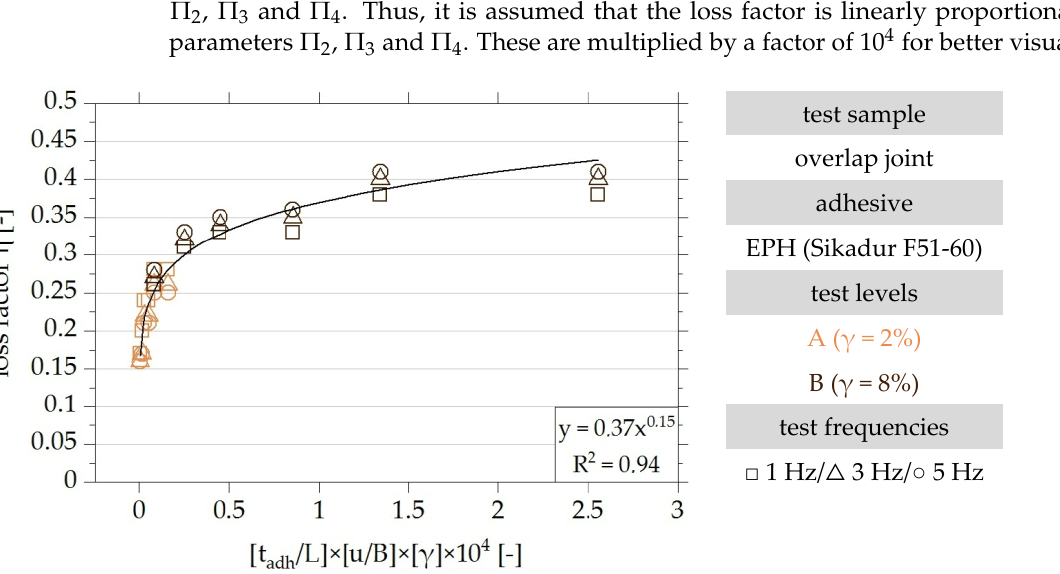
Figure 14. Dimensionless visualisation of the results of the experimental investigation of overlap joints made with the EPH adhesive and their approximation by a logarithmic regression function, taking into account the dimensionless parameters Π 2 , Π 3 and Π 4 based on [22].